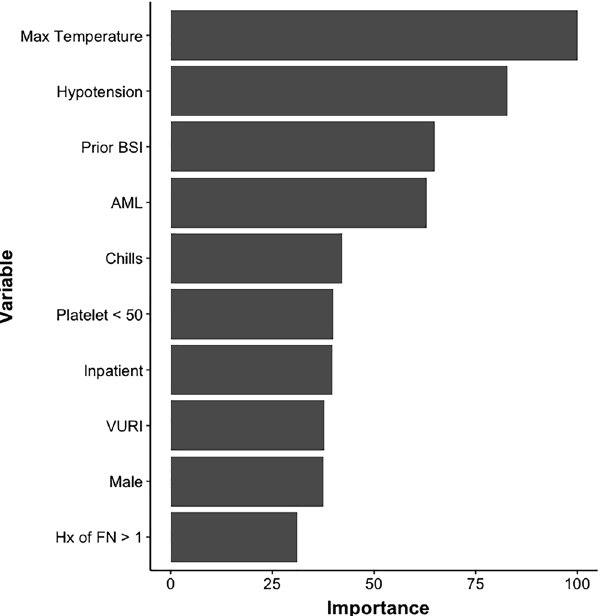
Figure 2. Depicts a list of variables important to the prediction of bactremia using the Random Forest model. Temperature height and hypotension recorded at time of presentation of FN episode, prior positive blood culture, and AML diagnosis were variables that contributed the most to BSI prediction.